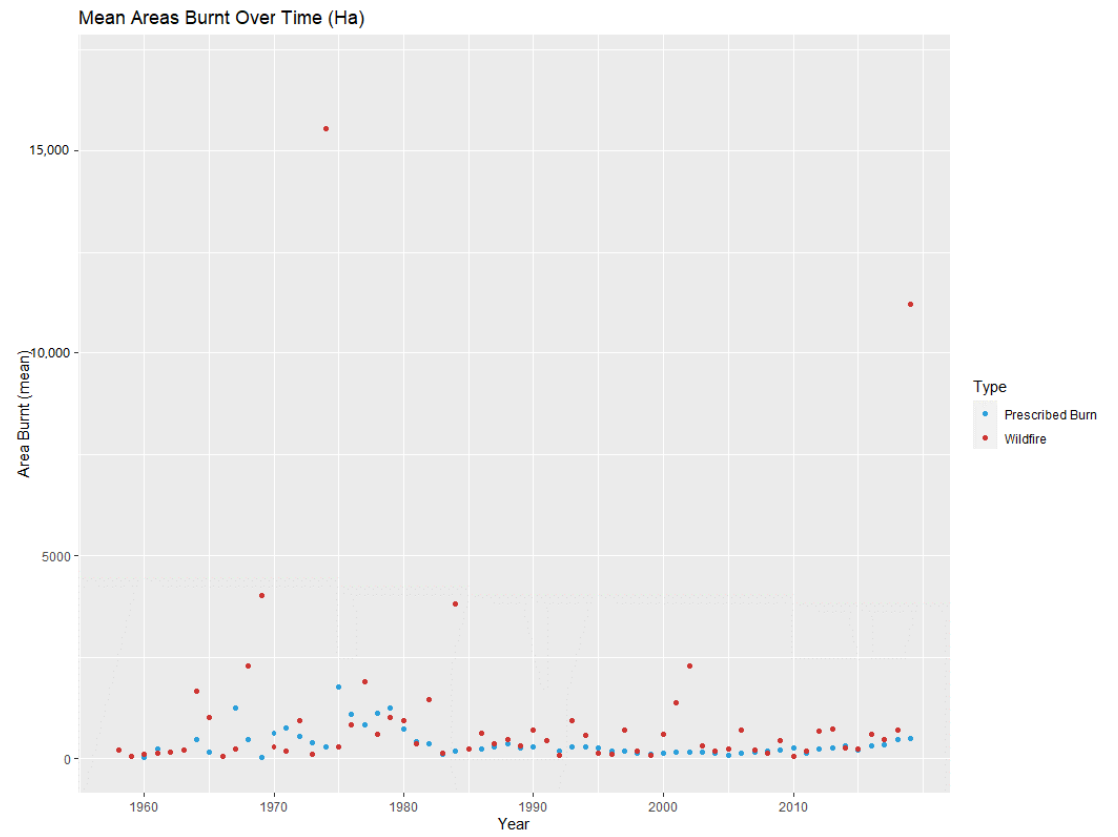
Figure 8. The trend of areas burnt over time.